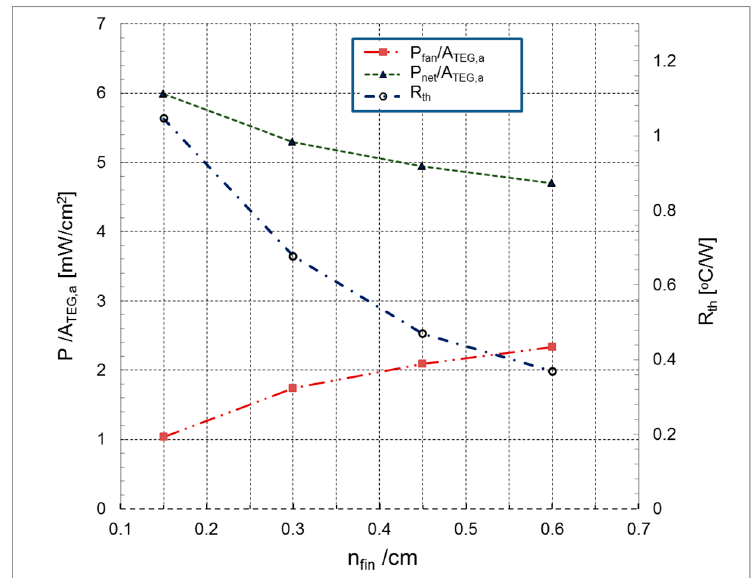
Figure 14. Variation of P / A TEG,a (P fan / A TEG,a or P net / A TEG,a ) and total thermal resistance ( Θ th = R th ) as a function of fin density (n fin /cm) .